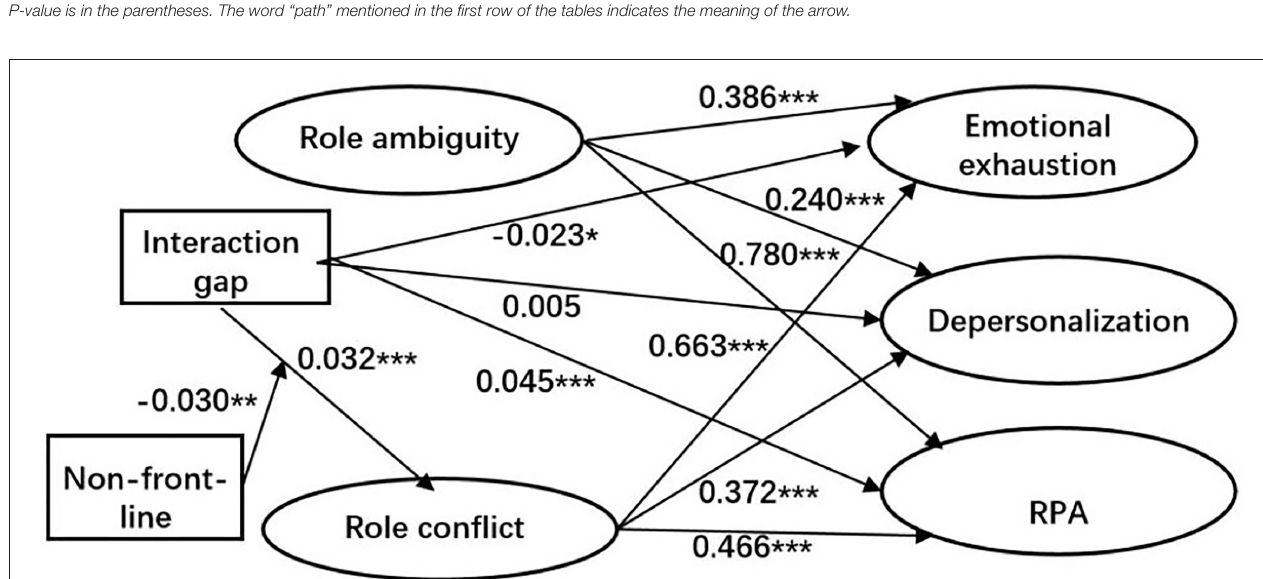
Direct effect Indirect effect Coef. Coef.